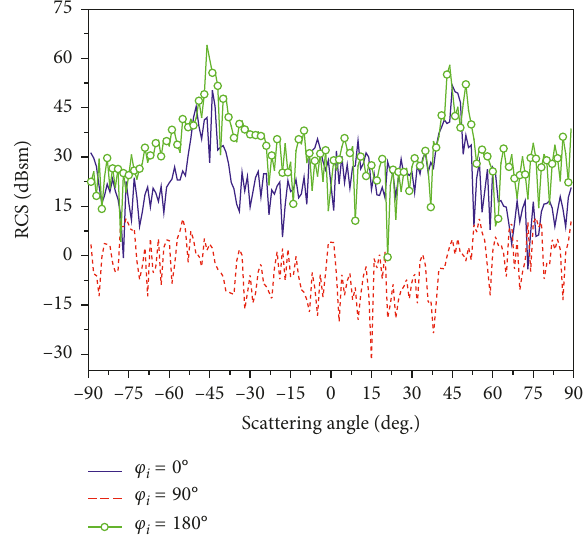
Figure 14: The change of RCS of the ship with scattering angle at different scattering